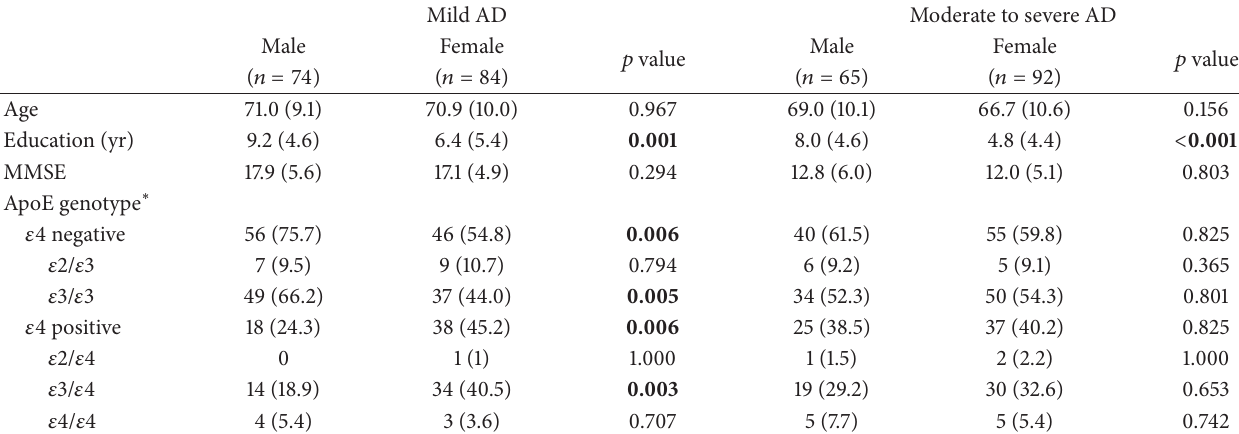
Table 1: Characteristics of subjects and ApoE genotype